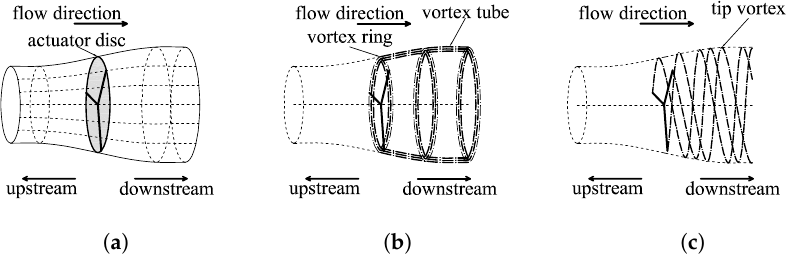
Figure 8. Schematic representation of different inflow and near-wake modelling approaches, distinguishing ( a ) the stream tube model for the momentum-balance method, ( b ) the free wake vortex ring model, and ( c ) the free vortex wake